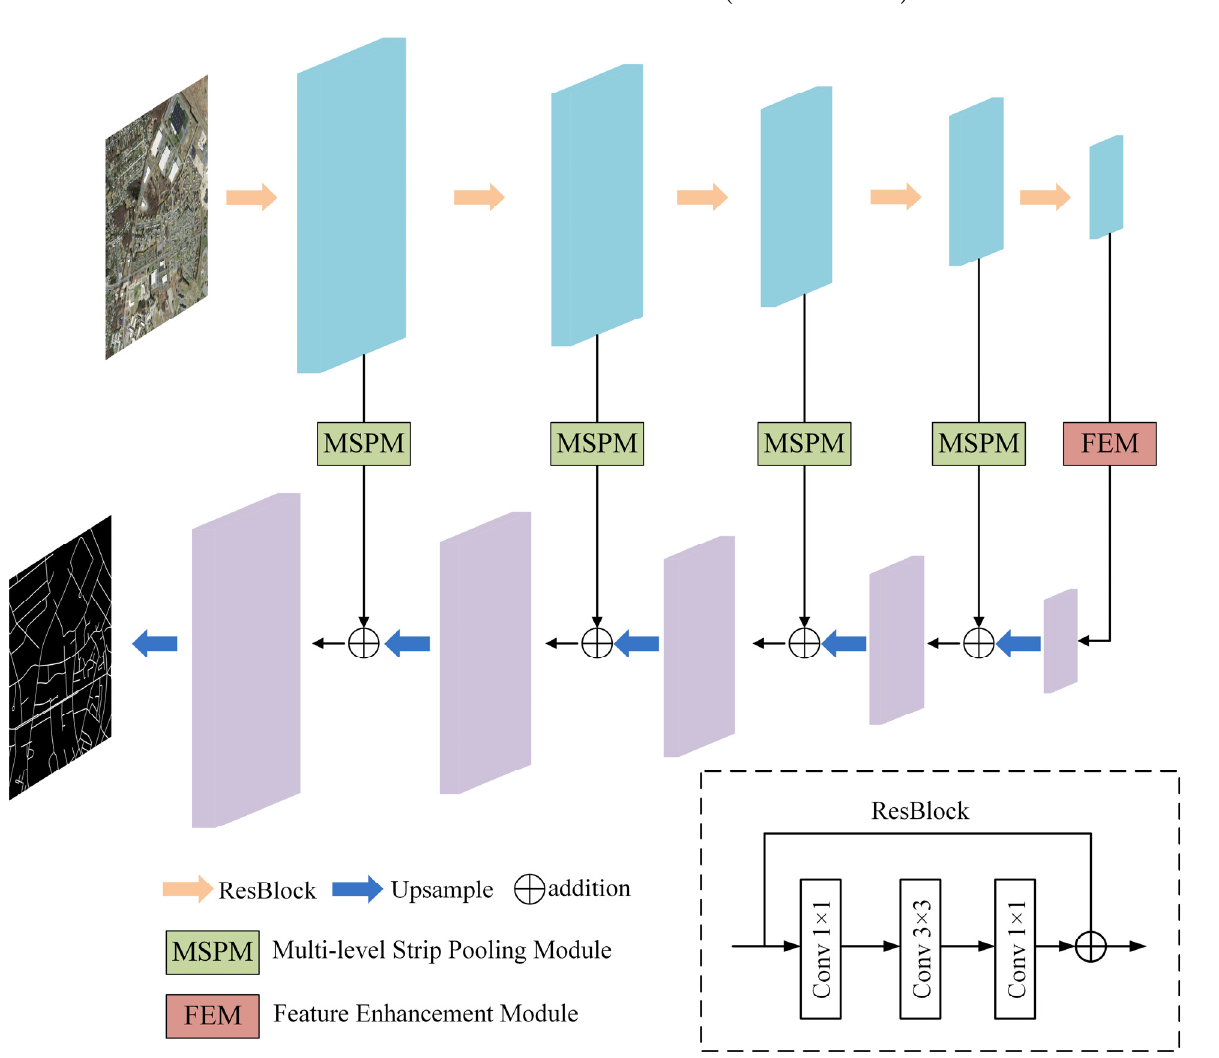
Figure 1. The architecture of MSPFE ‐ Net.